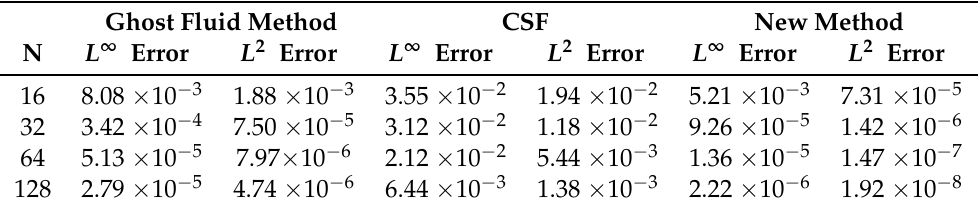
Table 1. Comparison between the new method and the numerical results obtained in [8] for the Ghost Fluid method and the CSF method for parasitic oscillations, at time t = 1.